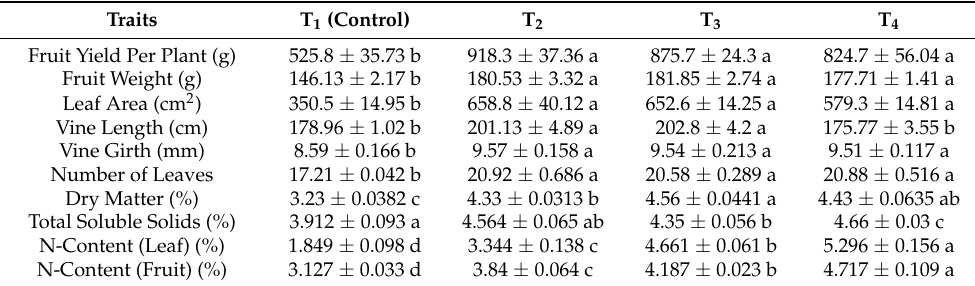
Figure 2. Graphical representation compares productivity-enhancing traits including Fruit Yield ( A ), Fruit Weight ( B ), Leaf Area ( C ), Vine Length ( D ), Vine Girth ( E ), Number of Leaves ( F ), Dry Matter ( G ), Total Soluble Solid ( H ), Leaf N-Content ( I ), and Fruit N-Content ( J ) in cucumber under soilless culture through Tukey–Kramer (HSD) test. Treatments sharing common letters revealed non-significant differences, and different letters depict significant differences ( p < 0.05). Table 4. Mean comparison for different productivity-enhancing traits of cucumber for different treatments under soilless culture based on Tukey–Kramer (HSD)